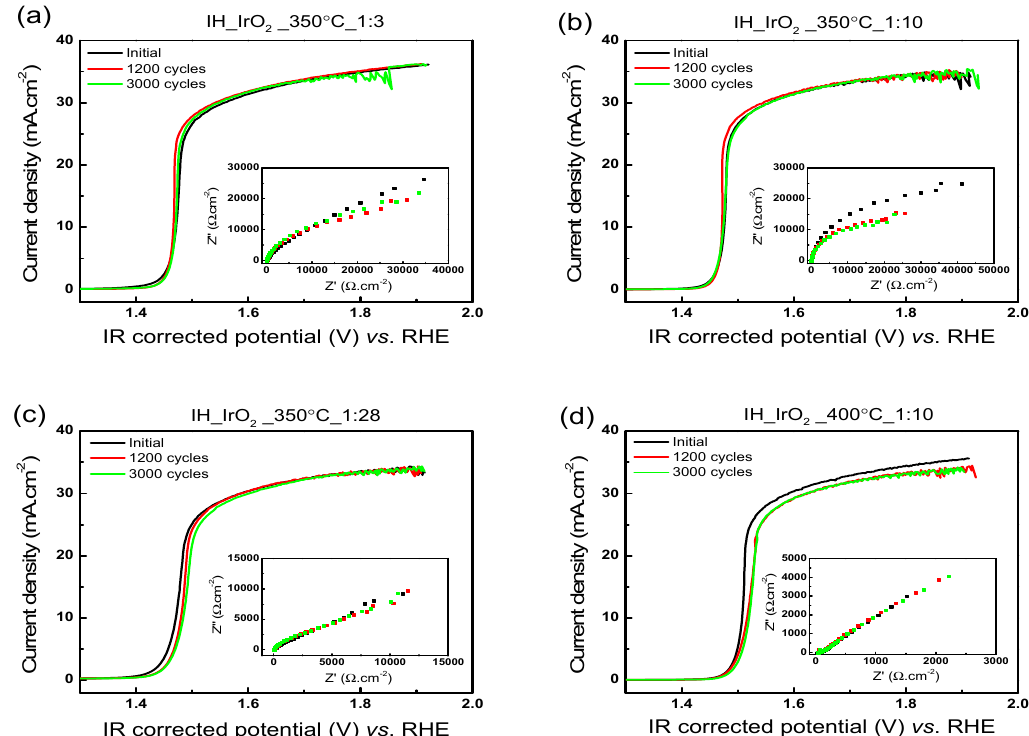
Figure 8. LSV analyses at 2 mV·s − 1 potential scan rate of the in-house IrO 2 electrocatalysts during the durability experiment. ( a ) IH_IrO 2 _350 °C_1:3, ( b ) IH_IrO 2 _350 °C_1:10, ( c ) IH_IrO 2 _350 °C_1:28 and ( d ) IH_IrO 2 _400 °C_1:10. Insets are of EIS analysis over durability experiment. Table 6. Anodic current density measured at 1.6 V vs. RHE during the durability